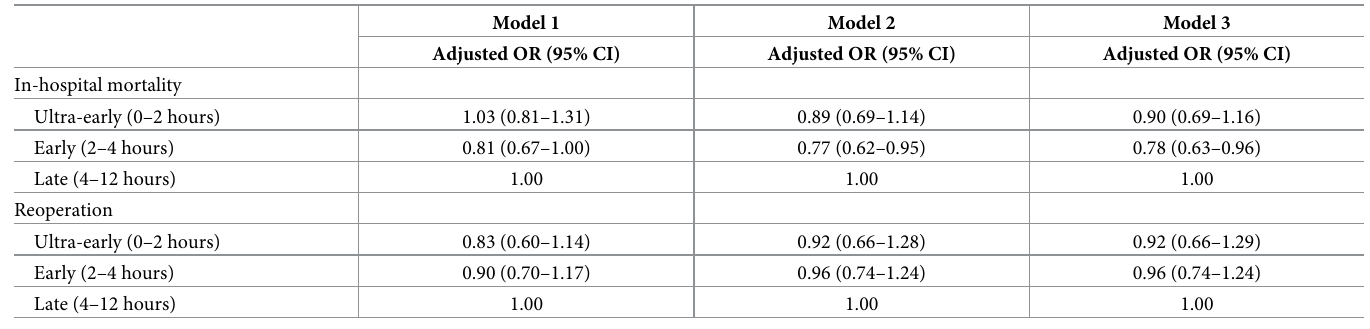
Table 4. Multivariable logistic regression analysis by time from emergency department visit to emergency